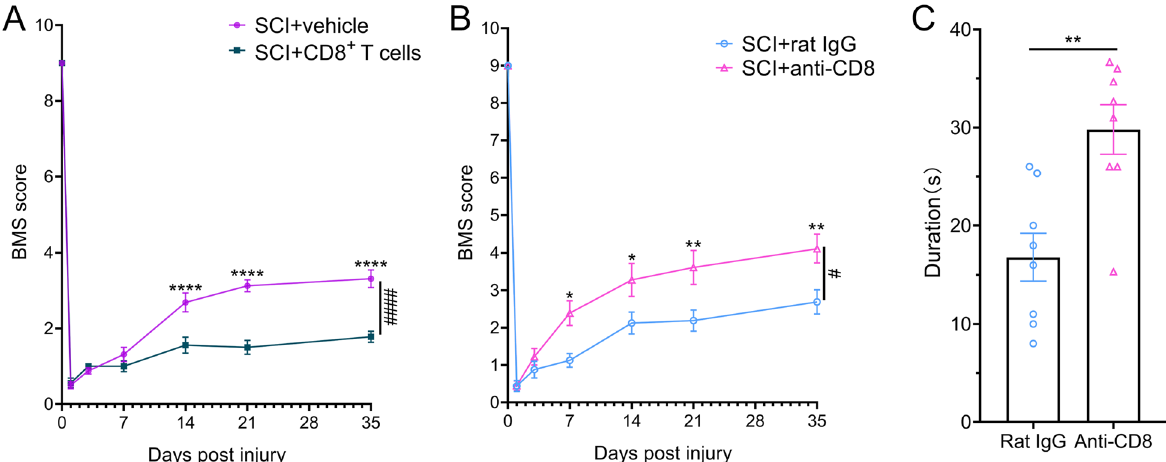
Fig. 2 Infiltration of CD8 + T cells hindered the locomotor functional recovery of SCI. A BMS score showing locomotor function in Rag2 − / − mice with adoptive CD8 + T‑cell therapy after SCI. n 8 independent mice. **** P < 0.0001, #### P < 0.0001, two‑way ANOVA‑RM with Bonferroni. B BMS = scores showing locomotor function in wild‑type mice with the administration of anti‑CD8 antibody after SCI. n 8 independent mice. * P < 0.05, ** P = < 0.01, #P < 0.05, two‑way ANOVA‑RM with Bonferroni. C Rotarod assays showing ameliorative locomotor functional recovery after administration of